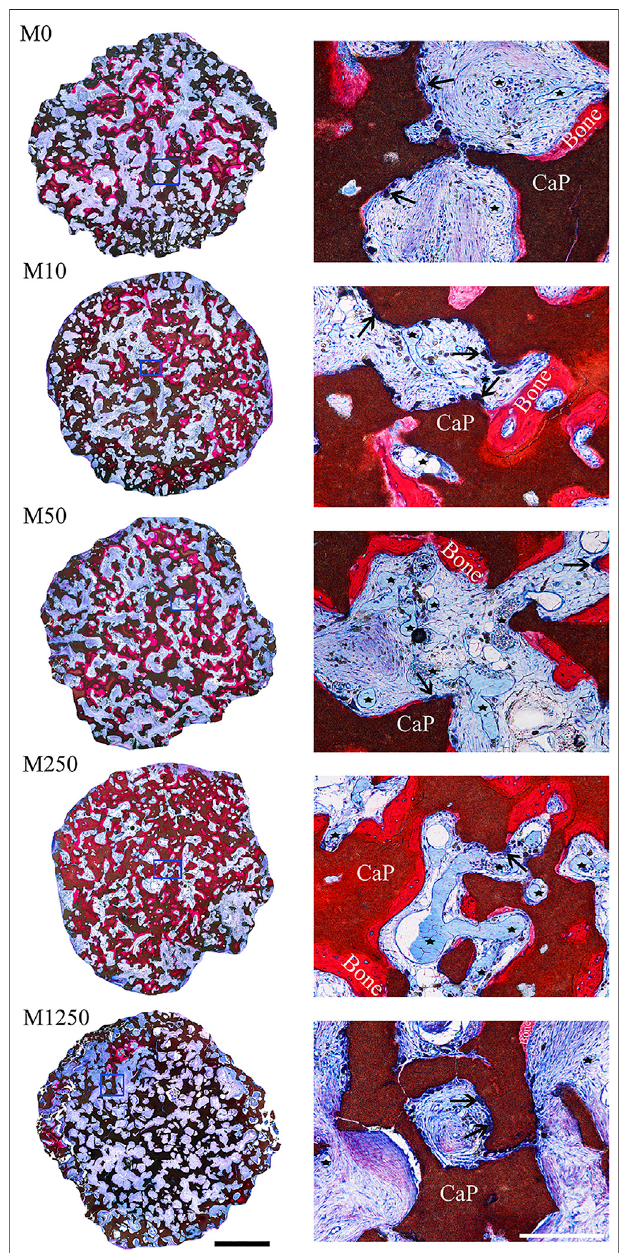
FIGURE 5 | Tissue response to icaritin-containing CaP discs implanted in muscle of dogs for 8 weeks. Left, histological overviews of M0, M10, M50, M250 and M1250 (scale (cid:2) 2 mm); Right, detailed light microscopic images of the selected region in the histological overviews (scale (cid:2) 250 µm) (un- decalci fi ed sections; methylene blue and basic fuchsin staining; Bone: bone tissue; CaP: CaP ceramic; star: blood vessel; arrow head: multinucleate giant cells).